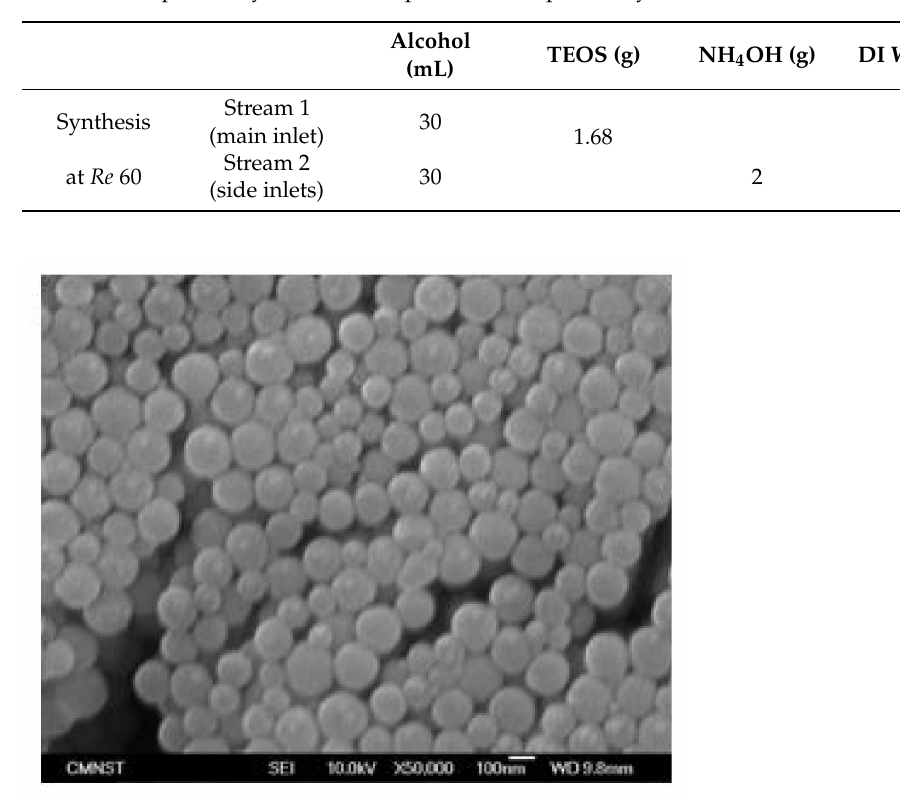
Figure 27. The SEM image of silica nanoparticles with an average diameter about 140 ± 20 nm at a high flow